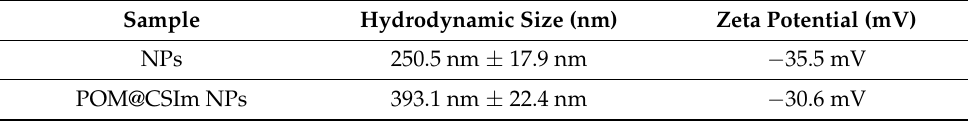
Table 1. Mean DLS and Zeta potential and electrophoretic mobility.